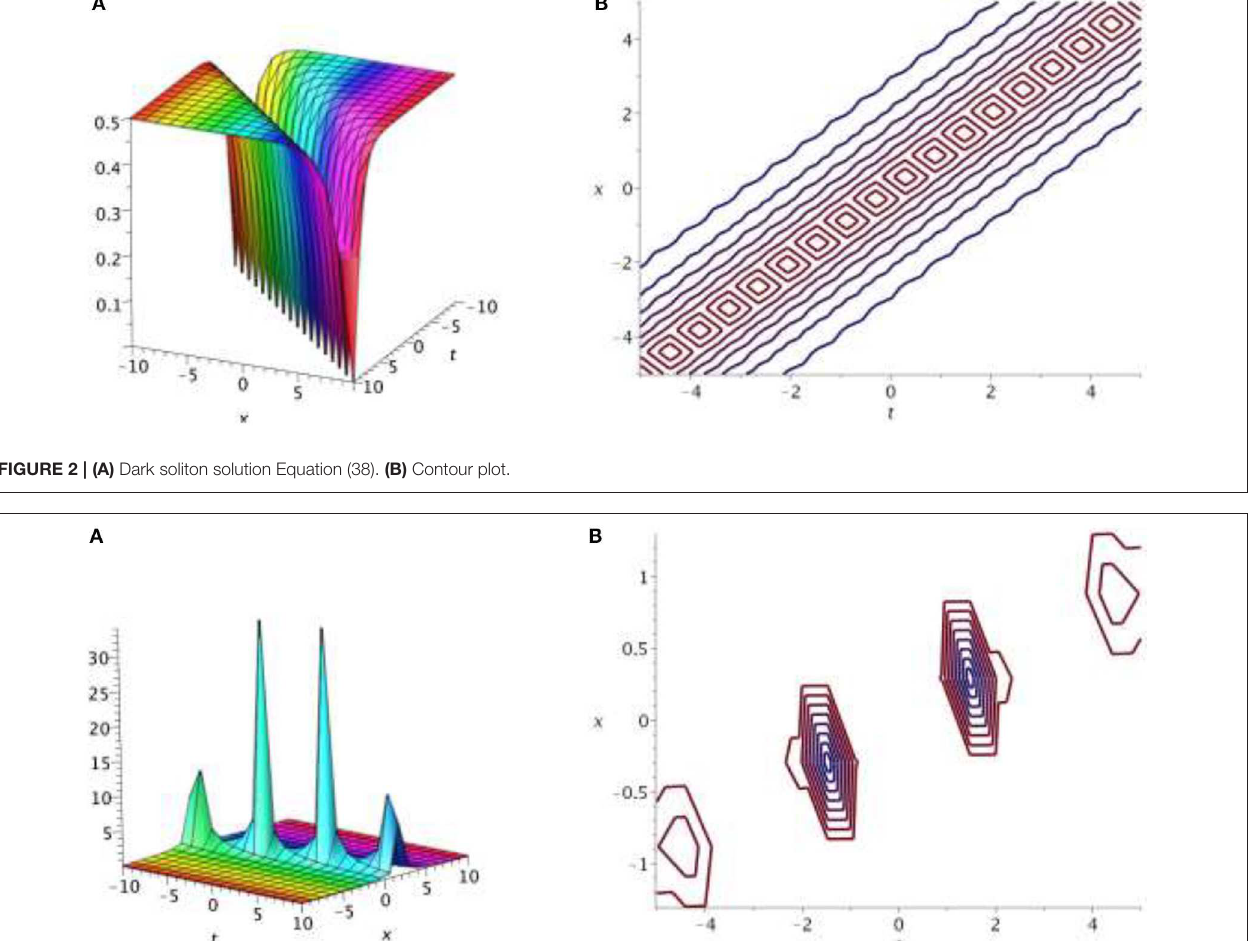
Frontiers in Physics |